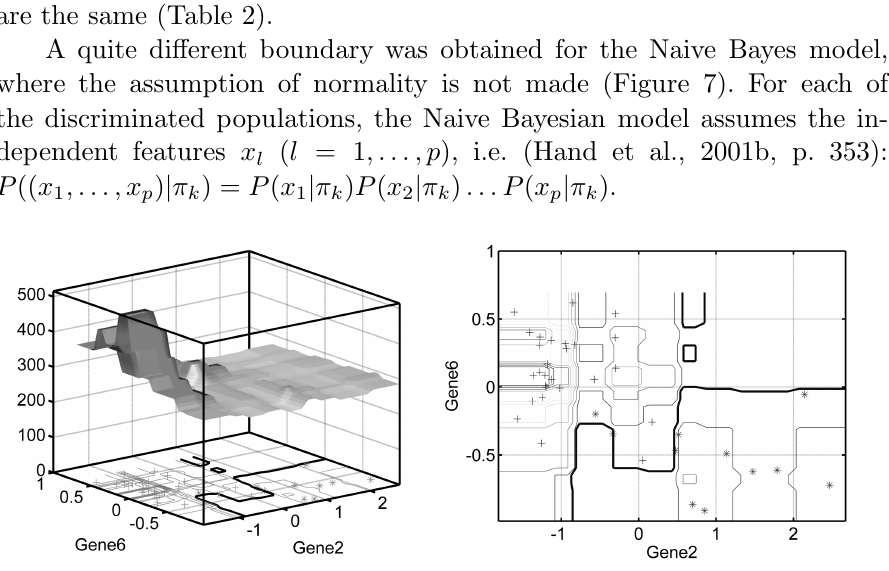
Figure 7. Density estimation and boundary of Naive Bayesian classifier; apparent error = 0.05, CV = 0.105 (SD <